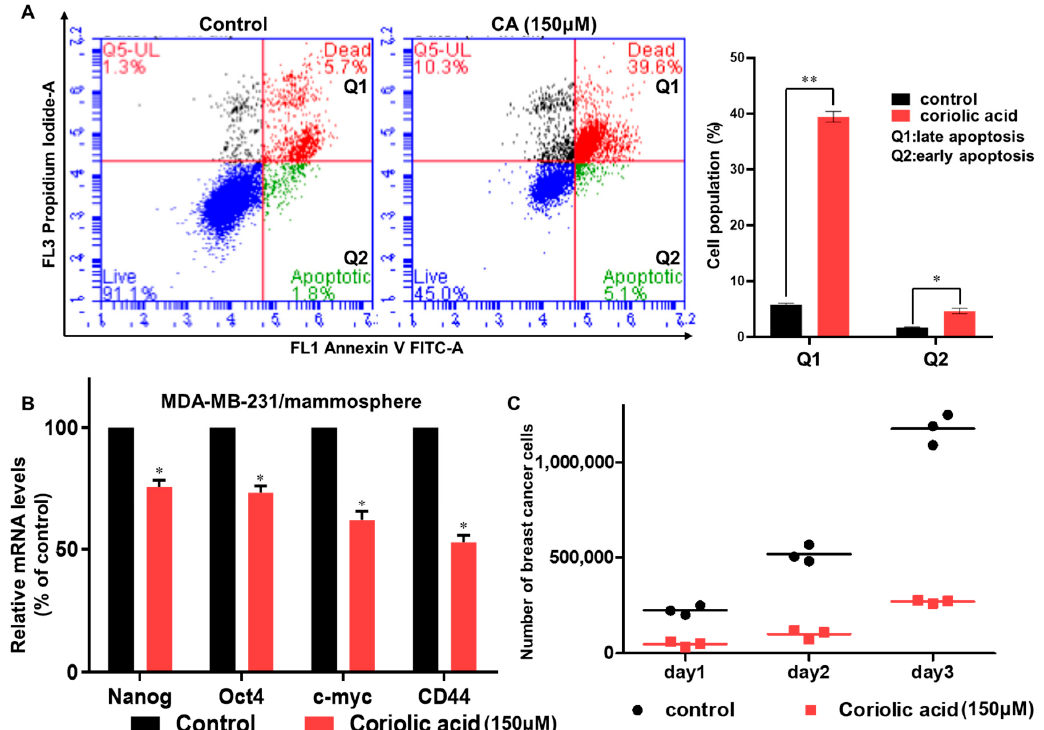
Figure 5. The e ff ects of coriolic acid on apoptosis, cancer stem cell markers and mammosphere growth. ( A ) Coriolic acid increased apoptosis in BCSCs. Mammospheres were plated and cultured with coriolic acid. We cultured mammospheres in ultra-low attachment 6 well plate for 5 days and then treated with 150 µ M of coriolic acid for 2 days. After collecting the cells, the cells were trypsinized to be single cells and washed with 1X phosphate-bu ff ered saline (PBS). The single cells (1 × 10 5 ) were counted and suspended with 100 µ L of 1X Annexin V binding bu ff er. We added 5 µ L of FITC Annexin V solution and 5 µ L of Propidium Iodide staining solution to each samples. Then, those are incubated for 15 min on room temperature. After washing with 1X Annexin V binding bu ff er, the cell pellet was analyzed using an Accuri C6 flow cytometer (BD, San Jose, CA, USA). Apoptosis was analyzed